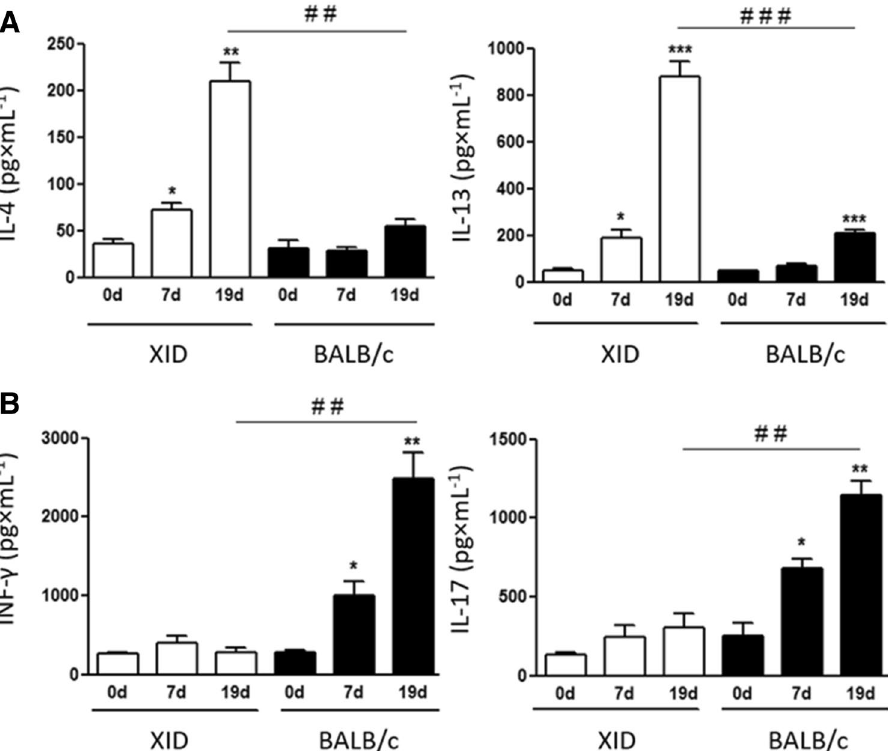
Figure 6. Cytokine dosage of bronchoalveolar lavage in XID and BALB/c mice. ( A ) Immunoenzymatic assay (ELISA) of the bronchoalveolar lavage (BAL) of XID and BALB/c animals before infection (0 d) and infected (7 d and 19d), for the measurement of cytokines IL-4 and IL-13 ( B ) and, IFN-γ and IL-17. The graphs show the results of 2 independent experiments (n = 5). (***p < 0.001; **p < 0.01; *p < 0.05) for comparative degree between days 0 and 7 (0 d × 7 d) or 0 and 19 (0 d × 19 d). ( ### p < 0.001; ## p < 0.01) for comparative degree between